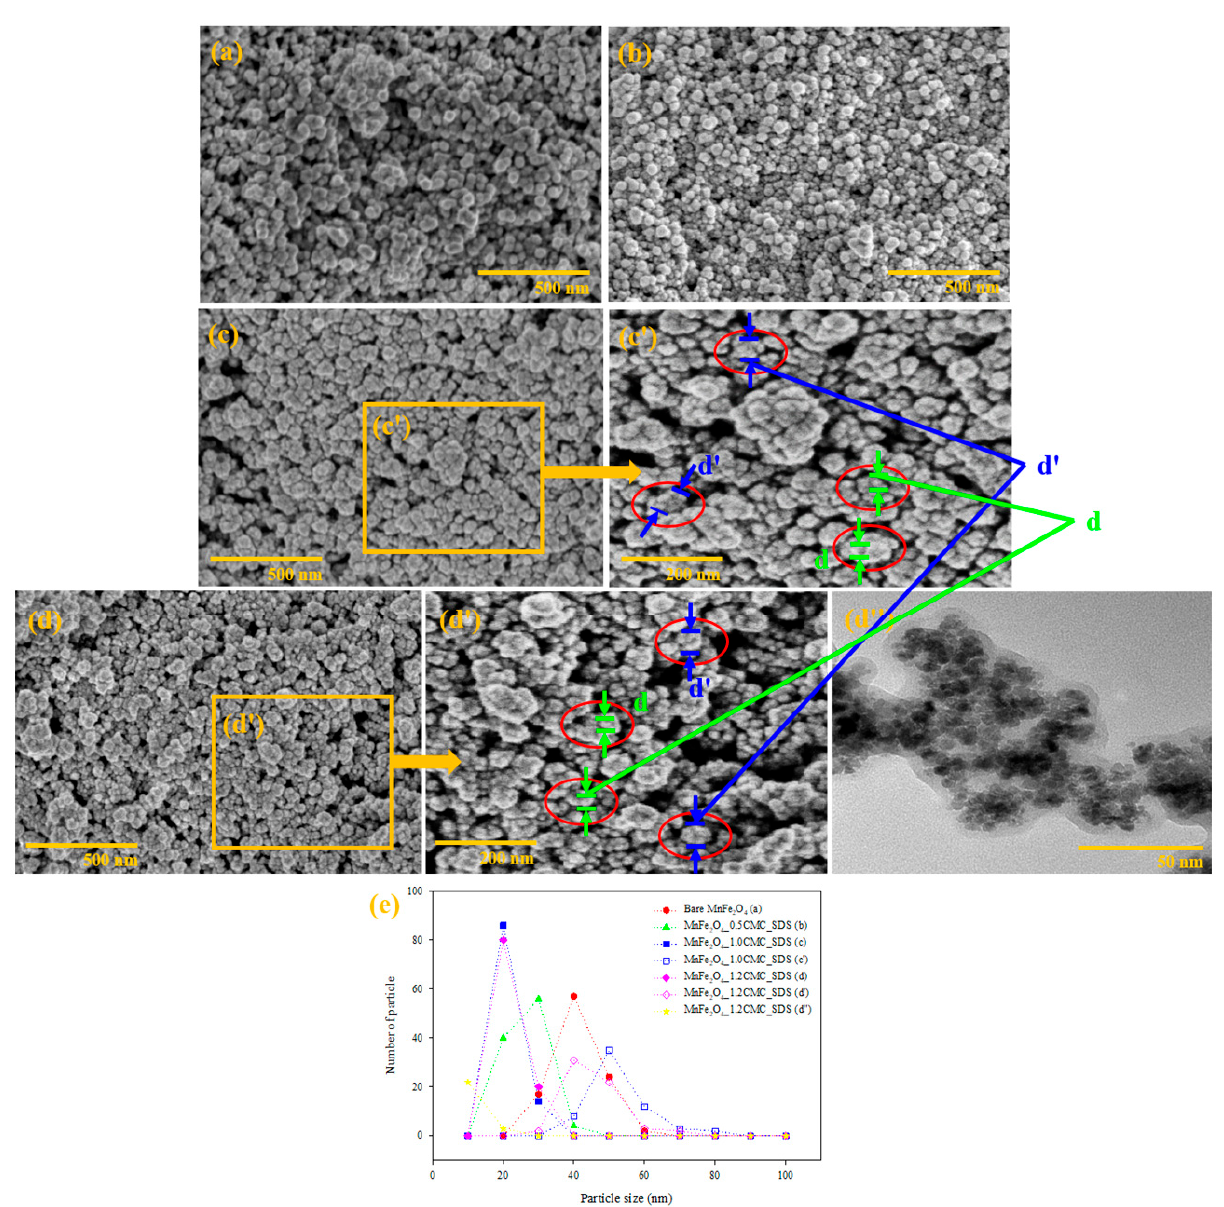
Figure 5. SEM and TEM images of the synthesized MnFe 2 O 4 ferrite nanoparticles at various SDS surfactant concentrations: ( a ) SEM image of bare MnFe 2 O 4 , ( b ) SEM image of MnFe 2 O 4 _0.5CMC_SDS, ( c ) SEM image of MnFe 2 O 4 _1.0CMC_SDS, ( c’ ) inset SEM image of ( c ) MnFe 2 O 4 _1.0CMC_SDS, ( d ) SEM image of MnFe 2 O 4 _1.2CMC_SDS, ( d’ ) inset SEM image of ( d ) MnFe 2 O 4 _1.2CMC_SDS, ( d” ) TEM image of MnFe 2 O 4 _1.2CMC_SDS, and ( e ) the particle size